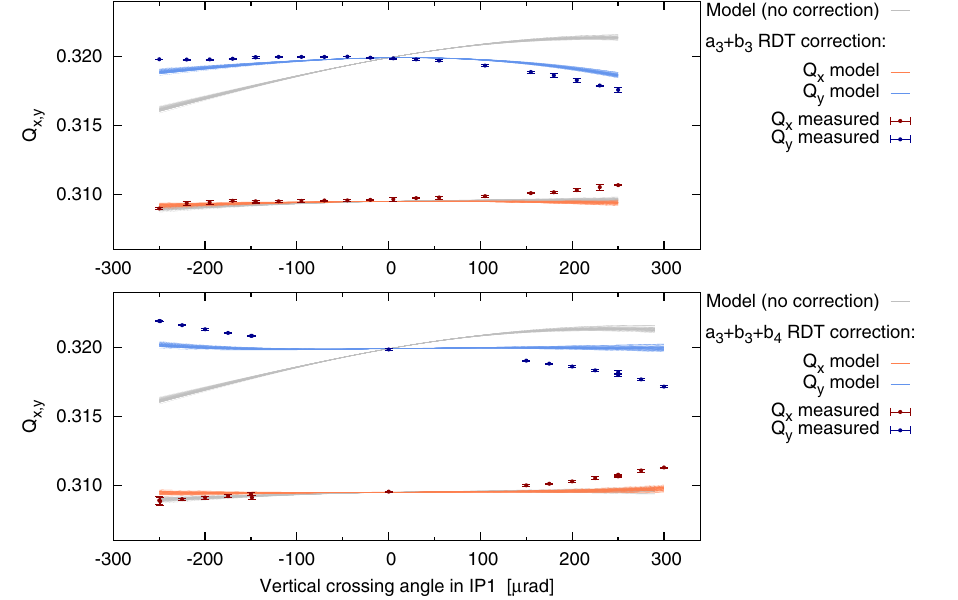
¼ 0 . 6 m. Two scans IP 1